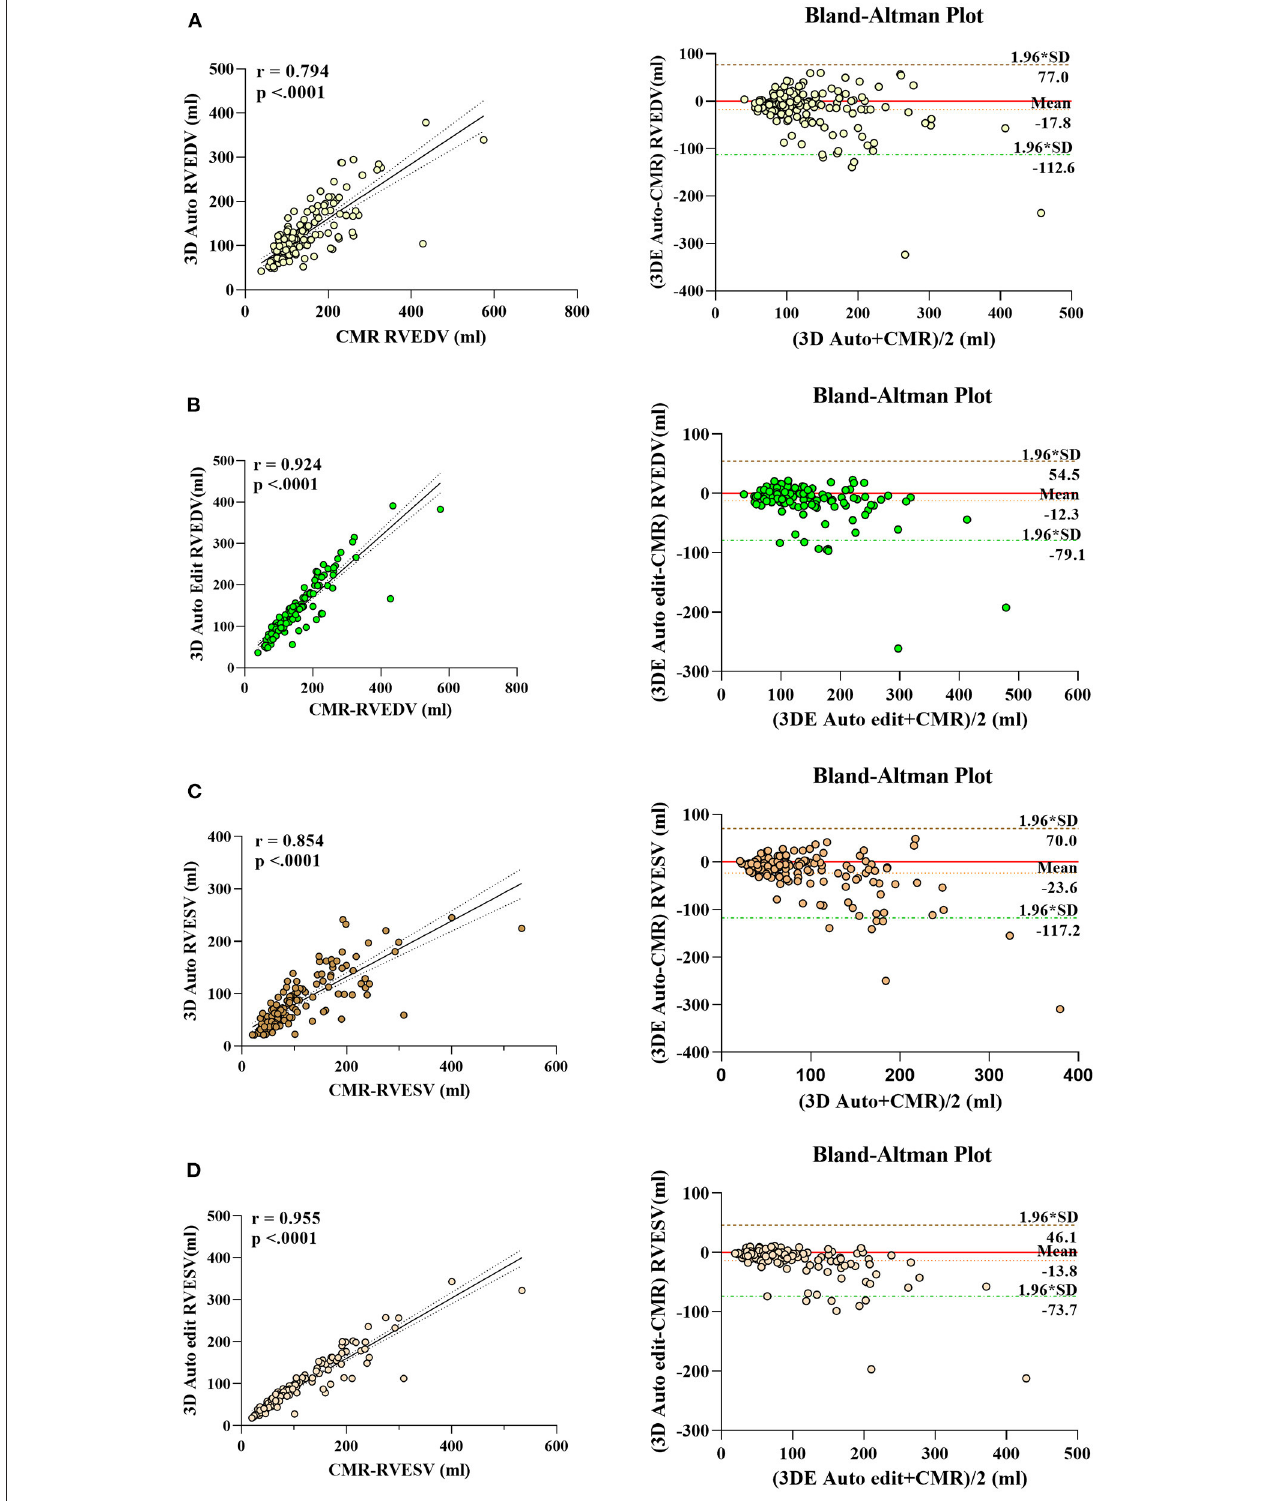
FIGURE 2 | Linear correlation and Bland–Altman analysis of RV volumes with 3D auto RV and edit method, with CMR. RVEDV auto (A) , RVEDV edit (B) , RVESV auto (C) , and RVESV edit (D) .